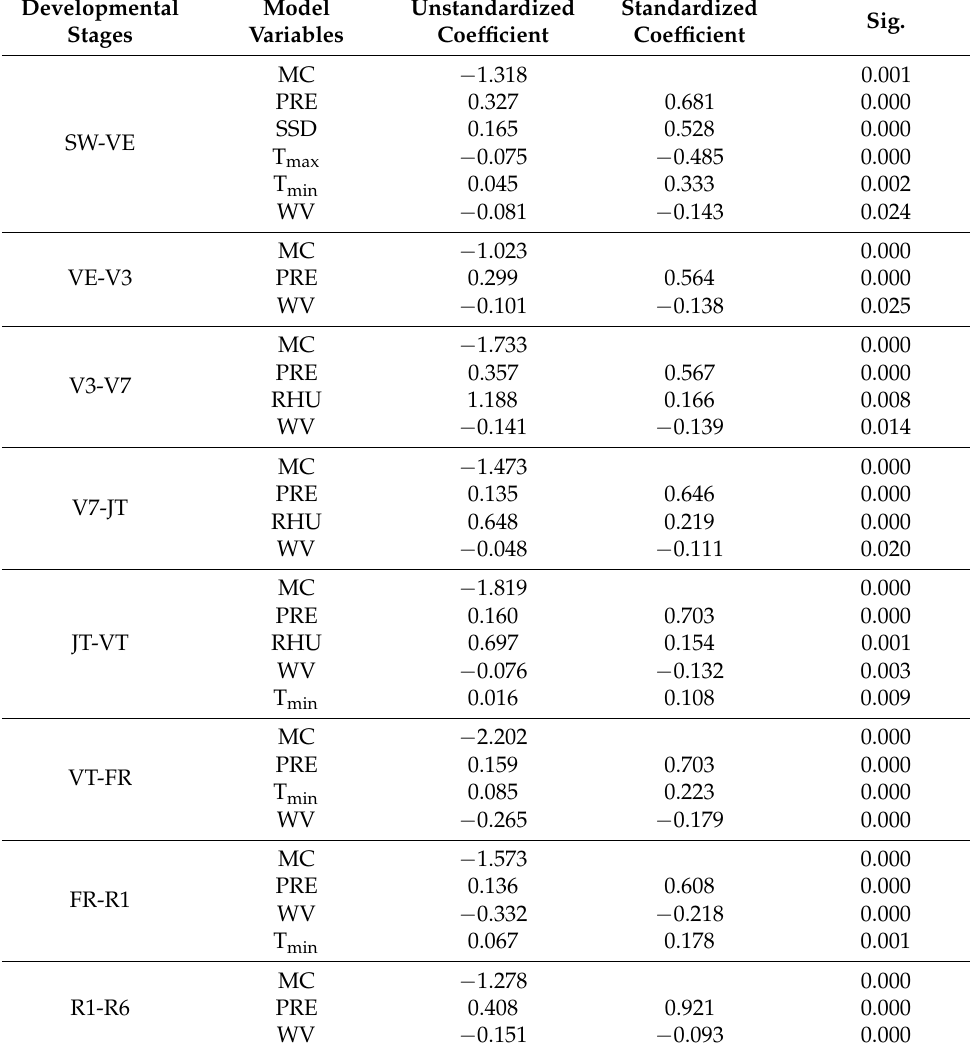
Table 4. Results of multiple stepwise regression models in different maize growth stages. Developmental Model Unstandardized Standardized Stages Variables Coefficient Coefficient